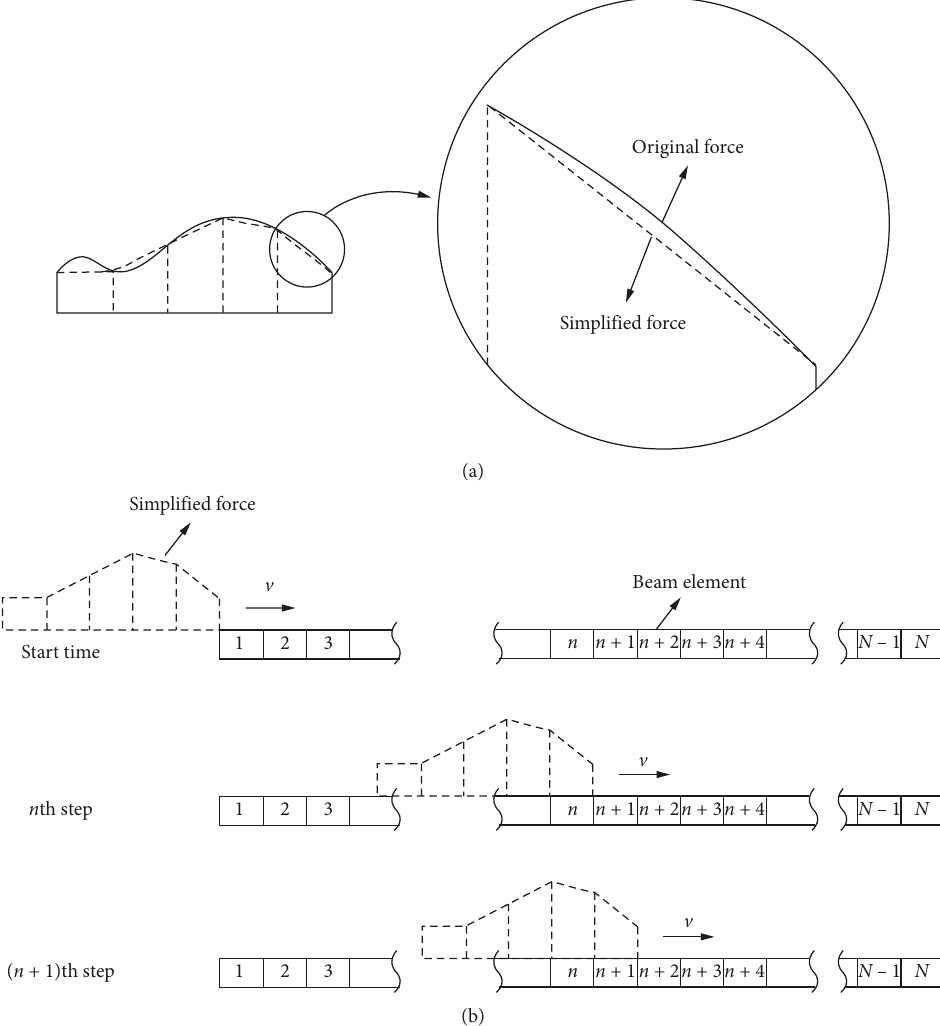
Figure 16: Finite element procedure for solving moving distributed force problem. (a) Original distributed force and the simplified force. (b) Simplified force at each time